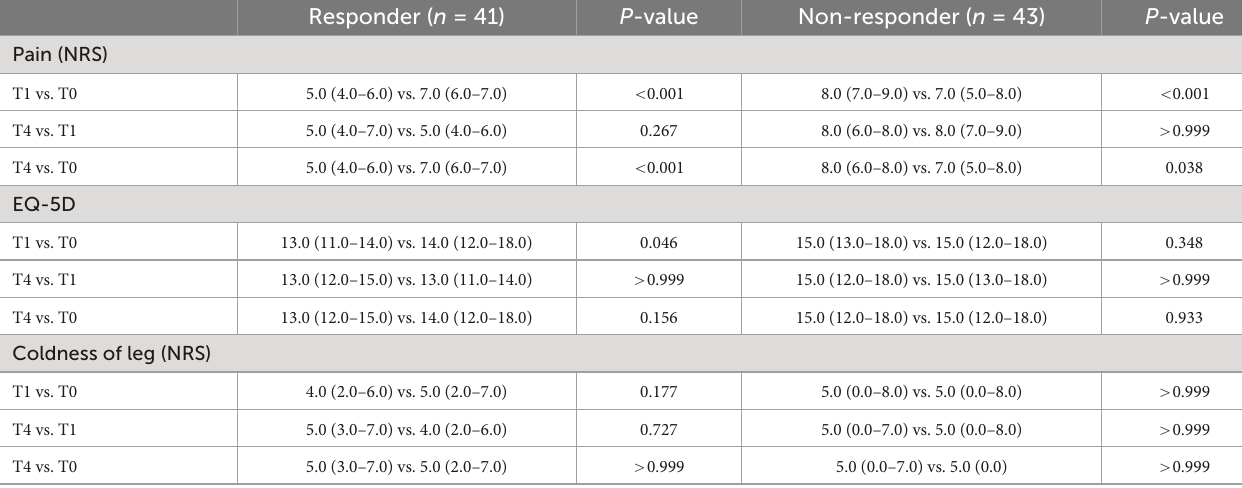
TABLE 4 Clinical outcomes over time within each groups.